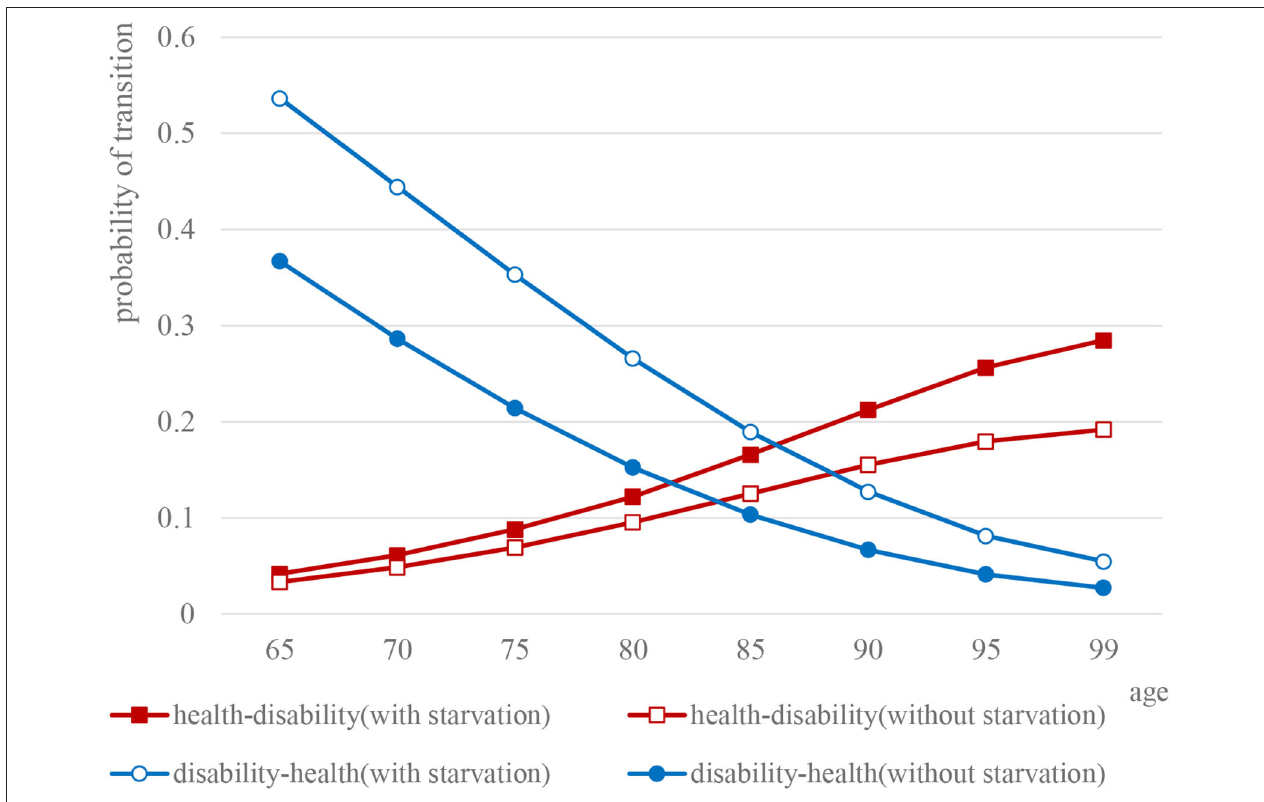
FIGURE 3 | Comparison of the probability curves of disability and health transition among elderly